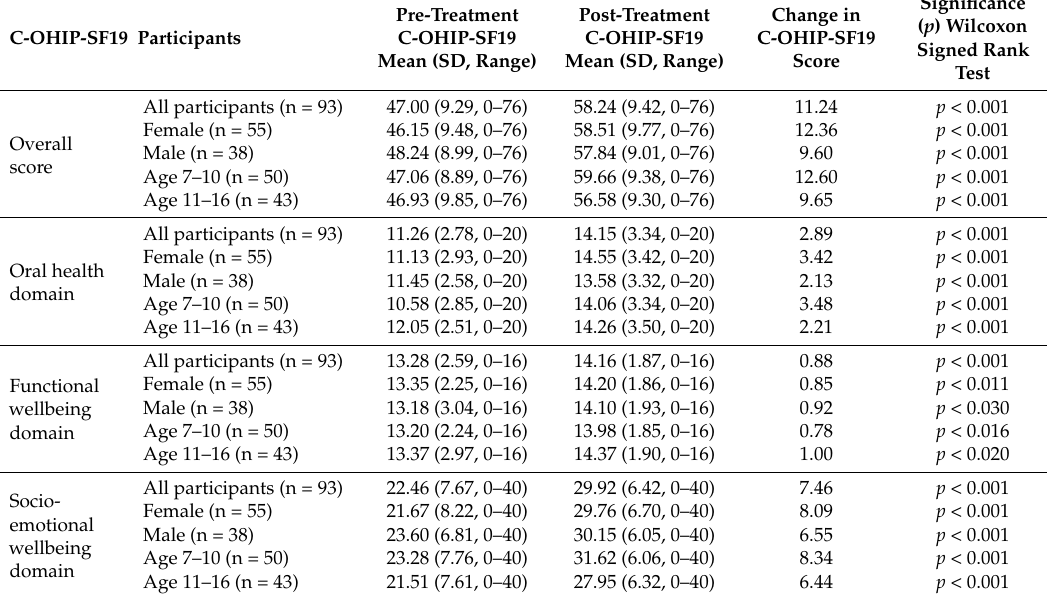
Table 2. Mean (SD) Child Oral Health Impact Profile (C-OHIP-SF19) scores before treatment (baseline) and one-month following treatment and according to